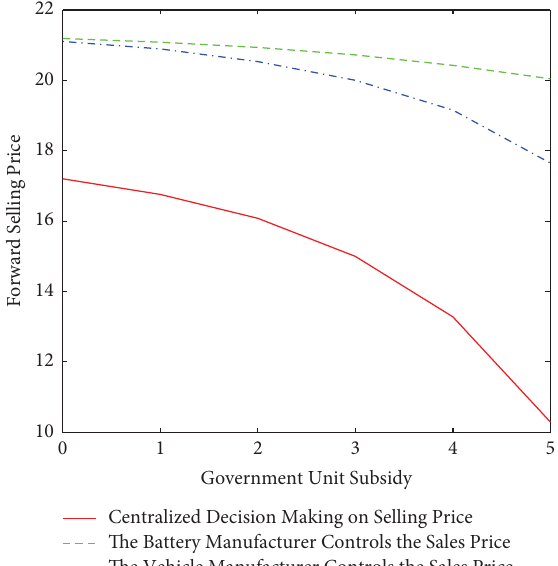
Figure 2: Te infuence of government subsidies on sales prices under diferent power structures.